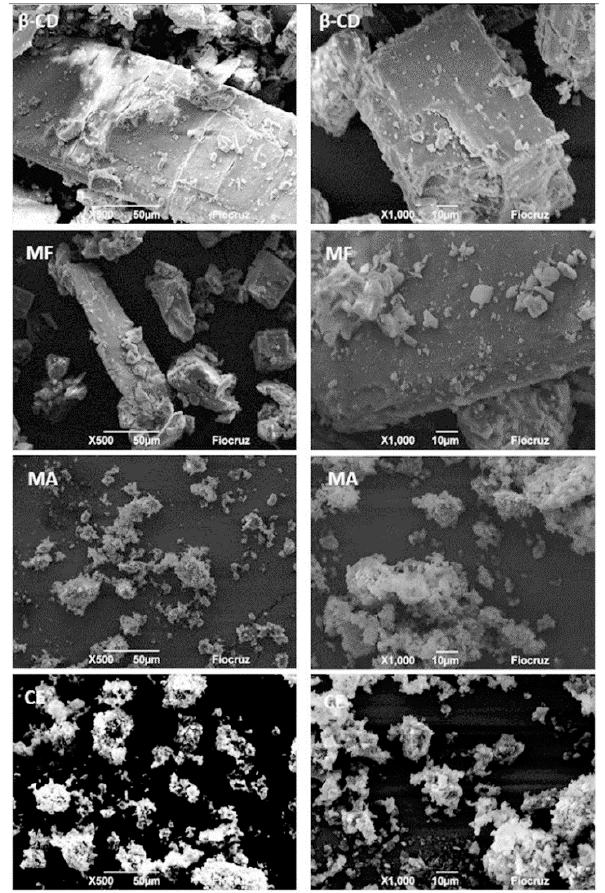
Figure 2. Scanning electron microscopy with magnifications of 50 μ m ( left ) and 10 μ m ( right ) obtained at 12 kV voltage acceleration. β cyclodextrin ( β -CD), physical mixture (MF), malaxation (MA), and co-evaporation (CE).